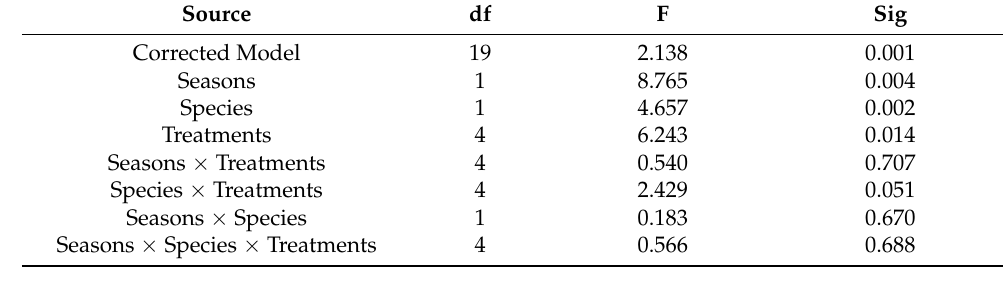
Table 3. Results of ANOVA for the G S in response to VPD.